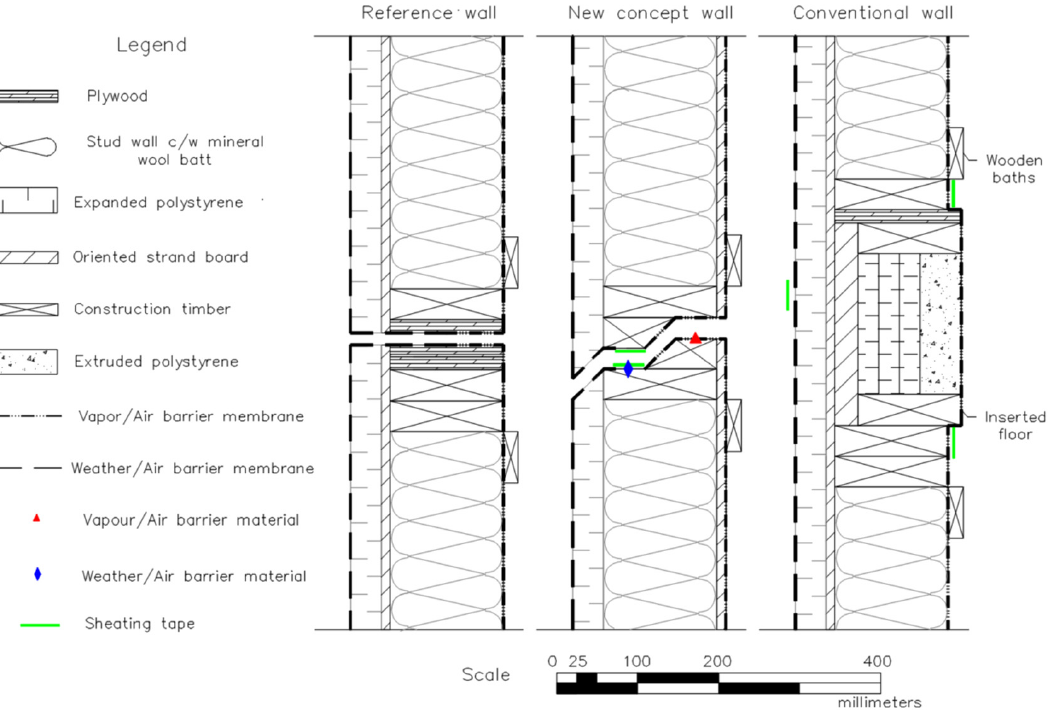
Figure 4. Tested structures: All composed of a 140 mm insulated wall cavity, 11 mm OSB panel, 25.4 mm rigid insulation panel, a polyethylene vapor barrier membrane, and a non ‐ woven olefin weather barrier membrane.